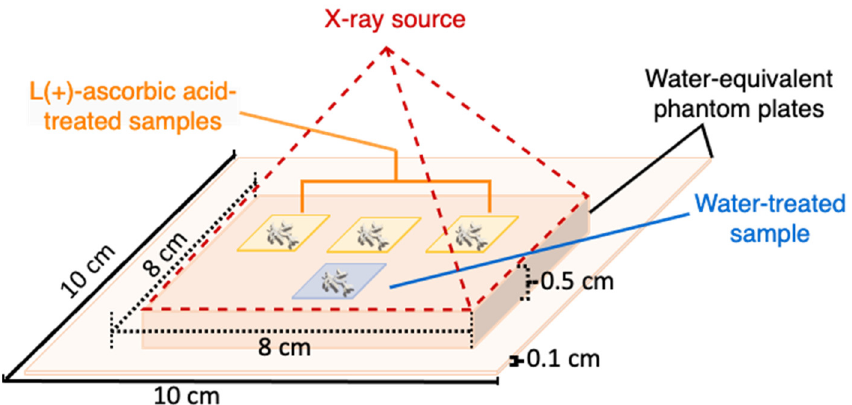
Figure 3. Schematic of the irradiation setup for the fingernail samples exposed to 20 Gy of X-rays.